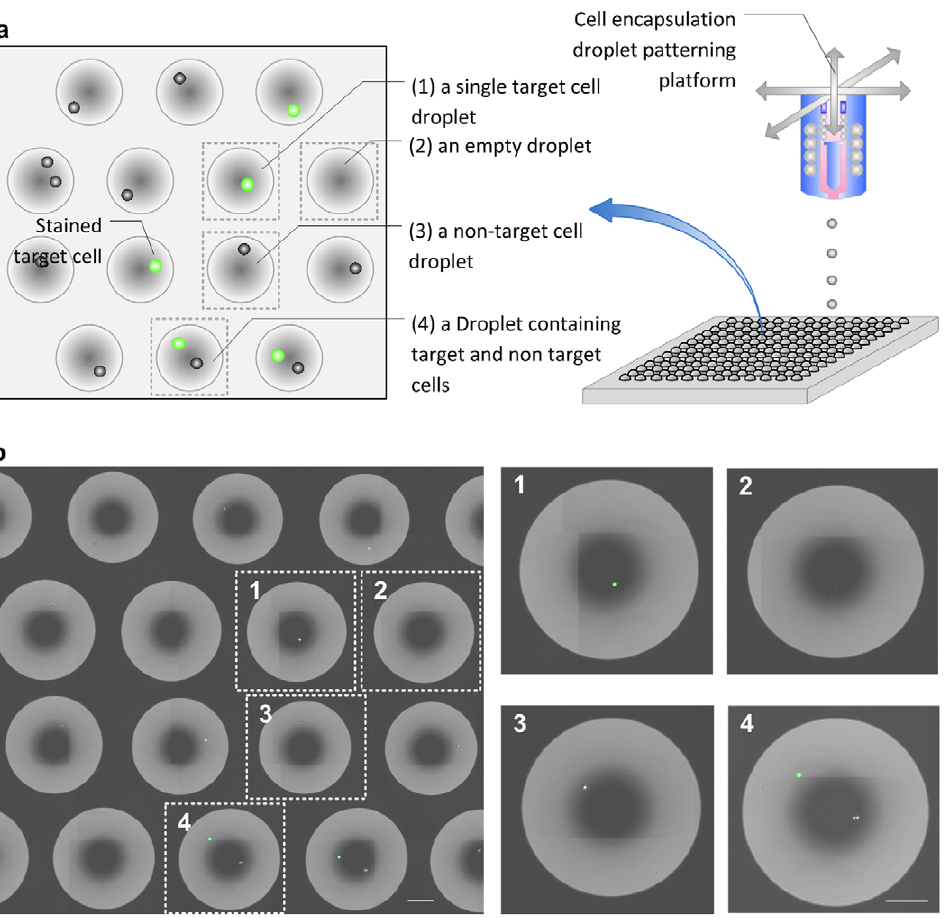
Figure 2. Patterned droplets. ( a ) Schematic droplet subarray showing four different cases of patterned droplets. Green colored circles indicated target cells. ( b ) Portion of a droplet array showing examples of each of the four different cases of patterned droplets, 1) single target cell droplet, 2) an empty droplet without cells, 3) a non-target cell droplet, and 4) a heterogeneous droplet containing target and non-target cells. Green fluorescent stained cells were target cells. Scale bars, 200 m m.